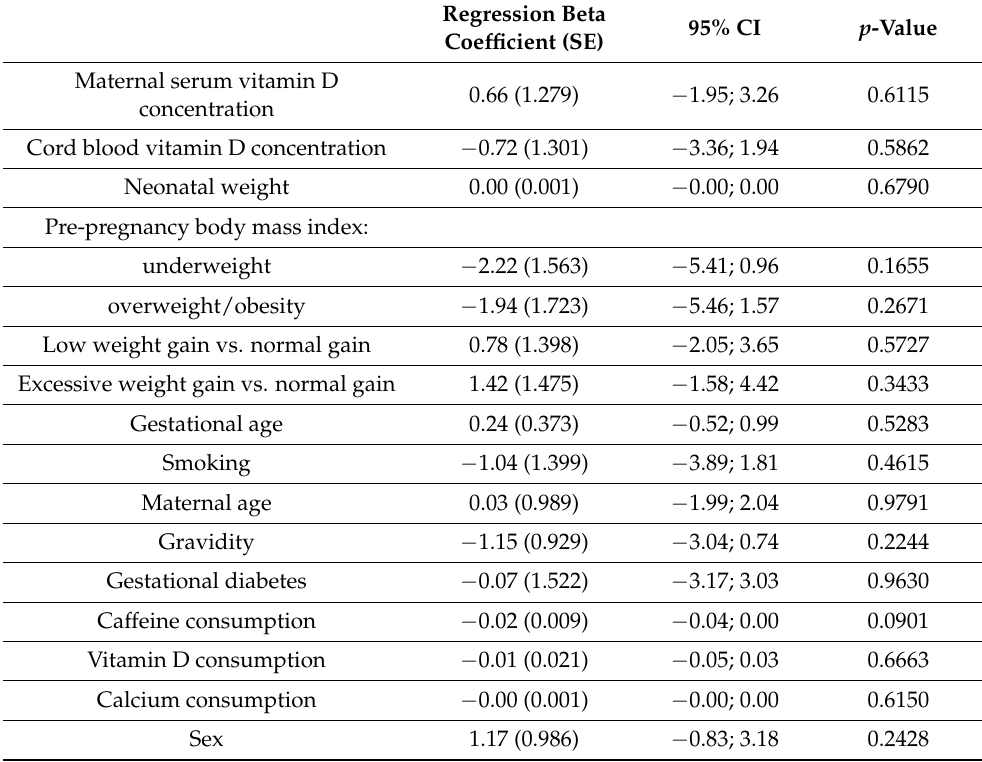
Table 3. Relationship between selected parameters and height at the age of